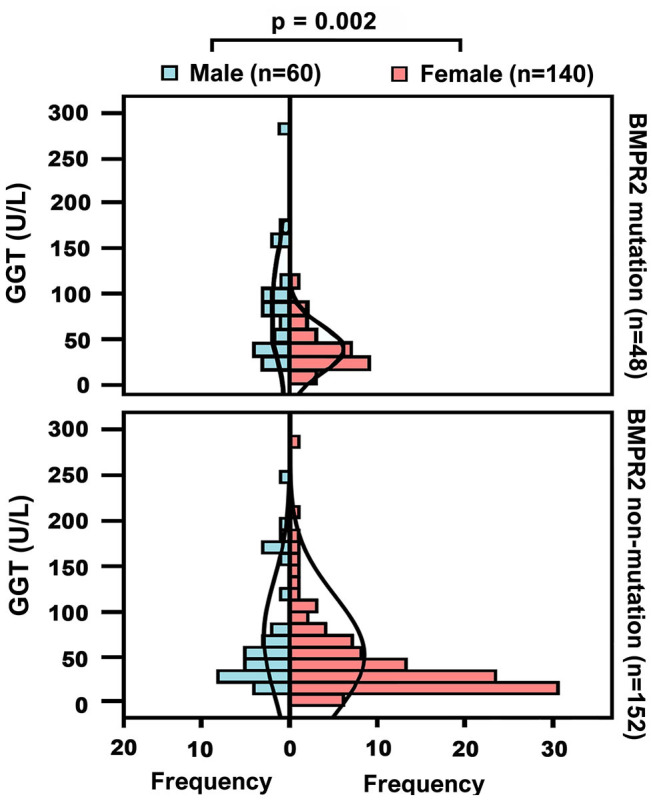
Baseline gamma-glutamyltranspeptidase (GGT) concentrations in different sex groups or patients with bone morphogenetic protein receptor type2 (BMPR2) mutation and non-mutation.